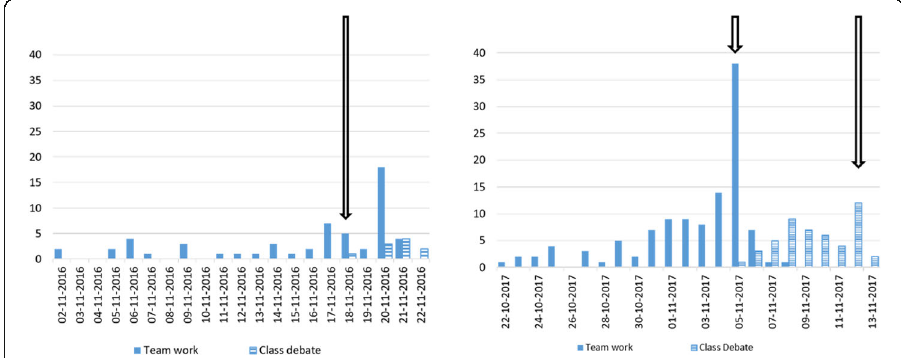
Fig. 9 Temporal distribution of posted messages in Topic 2 (Team work and Class debate). In the left side, the academic year of 2016/2017 and in the right side, the academic year of 2017/2018. The arrows show the deadlines for delivery of work and / or